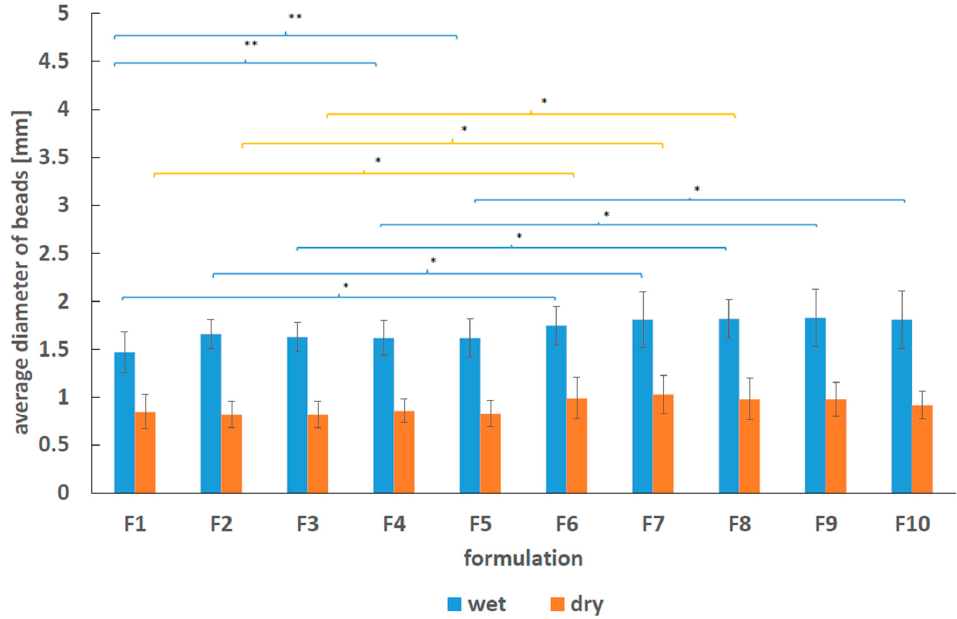
Figure 2. The average diameter of beads before and after drying. Significant differences between average diameter of beads, p < 0.05 (described by * for the influence of 5-ASA component, and by ** for the influence of the incorporation of synthetic polymer).